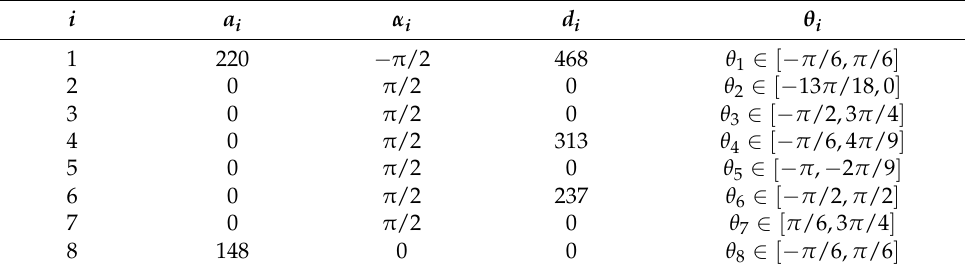
Table A1. Standard D-H